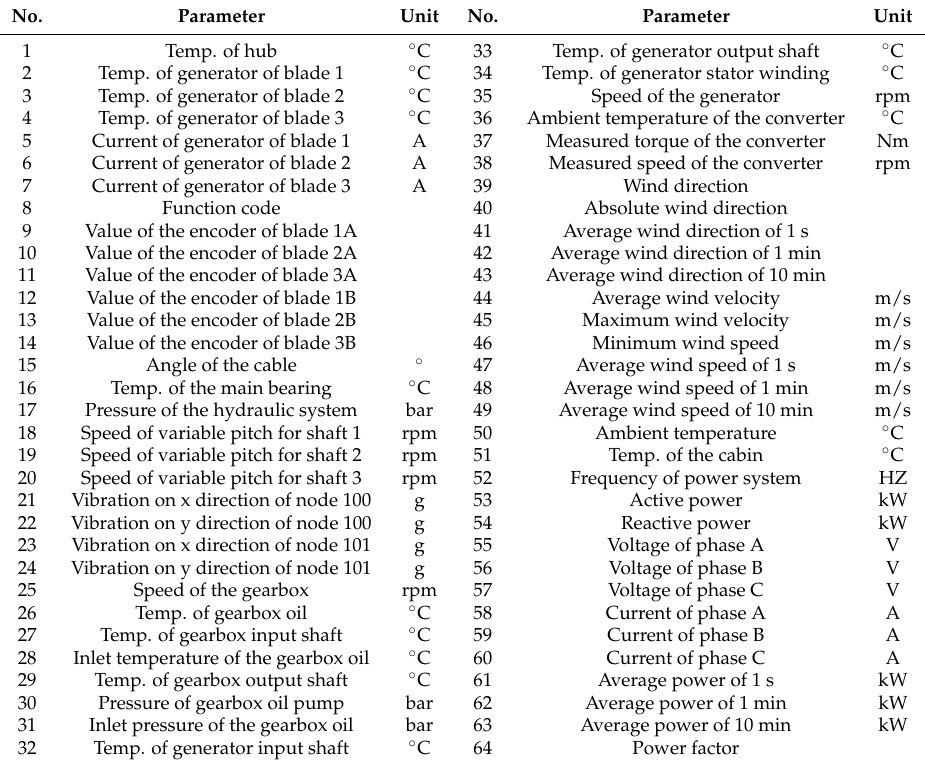
Figure 8. Image of the wind farm. Table 1. Parameters of WTs